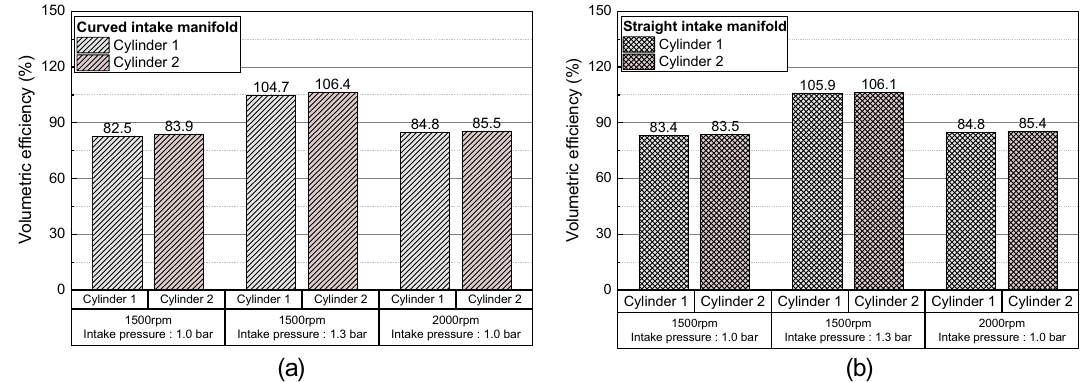
Figure 15. Volumetric of each cylinders: ( a ) curved intake manifold, ( b ) straight intake manifold. Simulation condition Curved manifold (%) Straight manifold (%)